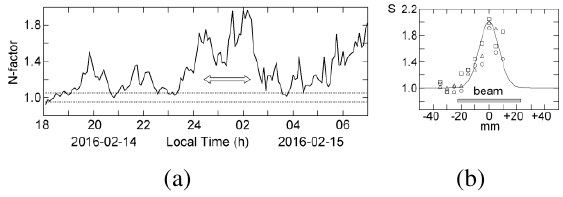
Fig. 3. Temporal profile of the backscatter